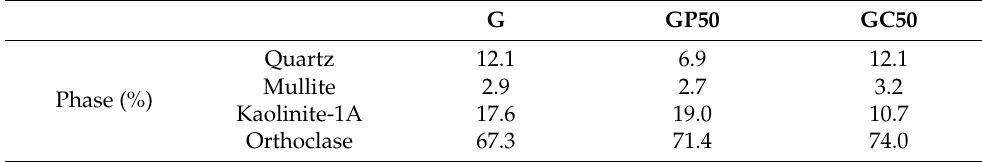
Table 4. Quantitative analysis of foamed geopolymer and composite materials with different